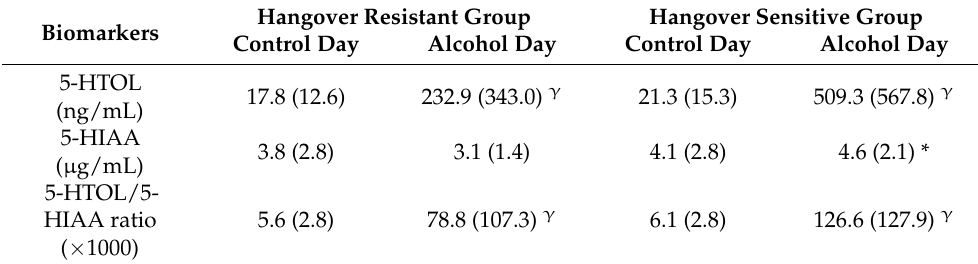
Mean and standard deviation (SD, between brackets) are shown. Significant differences ( p < 0.05) between the hangover resistant group and hangover sensitive group are indicated by *. Abbreviation: BAC = blood alcohol concentration. Table 3. Biomarker assessments.